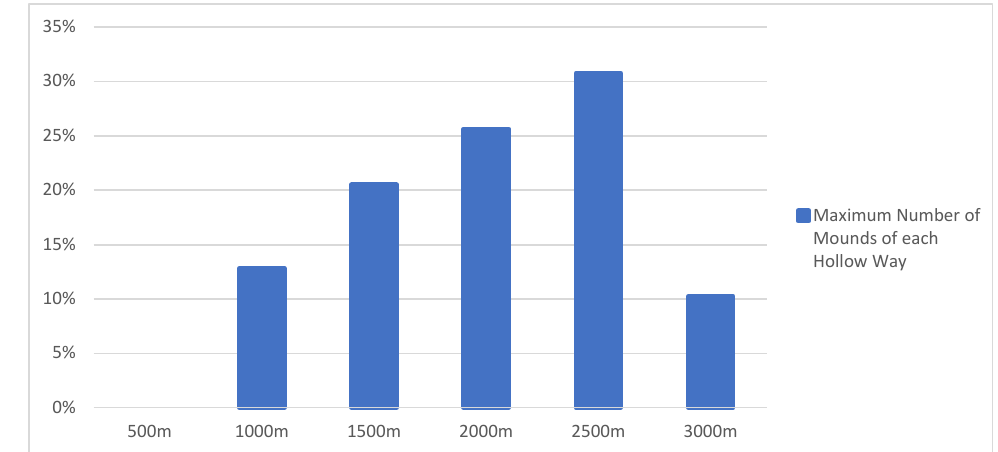
Figure 14. Maximum number of mounds of each hollow way in dependency on the radius. 5. The percentage of hollow ways with a least one mound confirms this as well, as be- way has its closest mound within a distance of 2500 m or more (Table 1).